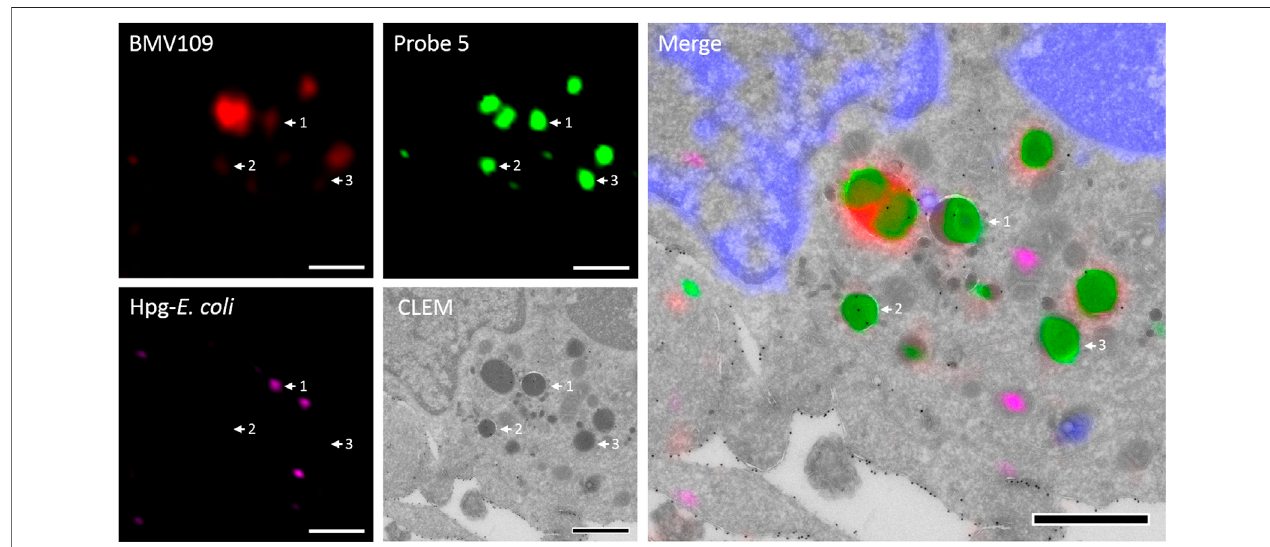
FIGURE 6 | Bio-orthogonal correlative light-electron microscopy. BMDCs were treated with Hpg- E. coli (purple) followed by treatment with probe 5 (green) and BMV109 (red). Cryosectioning was followed by on-section tandem click reactions and MHC II was visualized with 15 nm immunogold labeling. The nuclei were stained with DAPI (blue) and the confocal and TEM pictures were correlated. Scale bar represents 1 µm.